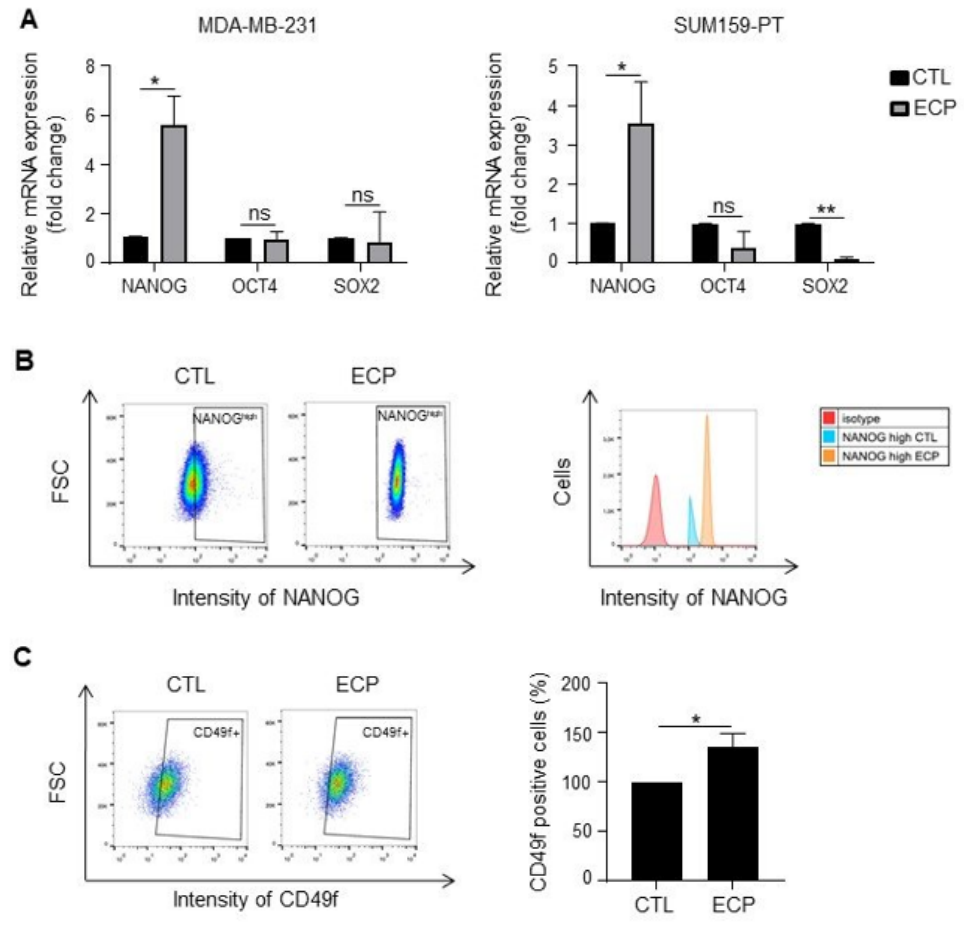
Figure 3. Expression of cancer stem cell markers in TNBC cells. Analyses were performed four days after ECP treatment. ( A ) Real-time PCR analysis of mRNA levels of pluripotency factors NANOG , OCT4 and SOX2 in MDA-MB-231 and SUM159-PT cells. RPLP0 mRNA was used to normalize variability in template loading. Data from control cells were set as 1, relative mRNA expression was evaluated by fold-change. ( B , C ) Flow cytometry analysis of cancer stem cell markers NANOG and CD49f in MDA-MB-231 cells. Cells were incubated with antibodies against NANOG and CD49f, and then analyzed by flow cytometry with FITC or APC filter, respectively. Isotype antibodies were used as controls. ( B ) Flow cytometry analysis of NANOG high population. Cells with fluorescence intensity ≥ log 10 2 were considered as NANOG high . Data were representative of 3 independent experiences ( C ) Flow cytometry analysis of CD49f positive sub-population. Quantitative graphics correspond to 3 independent experiments and illustrations are representative of 3 independent experiments. ns, not significant; *, p < 0.05; **, p < 0.01. Unpaired Student t